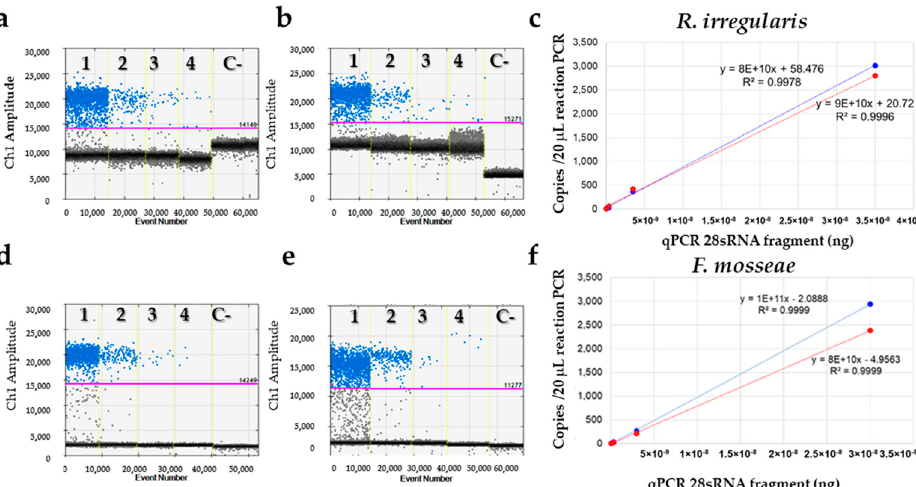
Figure 5. Performance of primer sets with various serially diluted targets in ddPCR. ( a , b , d , e ), The ordinate scales indicate fluorescent amplitude. The pink line is the threshold, above which are positive droplets (blue) containing at least one copy of target DNA and below which are negative droplets (gray) without any target DNA. Samples are divided by the vertical dotted yellow line. ( a ) Ten-fold serial dilutions of R. irregularis S1_V1 qPCR fragment (from 3.5×10 − 8 to 3.5×10 − 11 ng/reaction); ( b ) 50 ng/reaction of AMF nonhost DNA from Quercus ilex , oak spiked with ten-fold serial dilutions of S1_V1 qPCR fragment; ( c ) linear regression of serial dilutions analyzed in ( a ) (blue line) and ( b ) (red line); ( d ) ten-fold serial dilutions of F. mosseae S10_V3 qPCR fragment (from 2.8 × 10 − 8 to 2.8 × 10 − 11 ng/reaction); ( e ) 50 ng/reaction of AMF nonhost DNA from Quercus ilex L., oak, spiked with ten-fold serial dilutions of S10_V3 qPCR fragment; ( f ) linear regression of serial dilutions analyzed in ( d ) (blue line) and ( e ) (red line). C- = negative control.